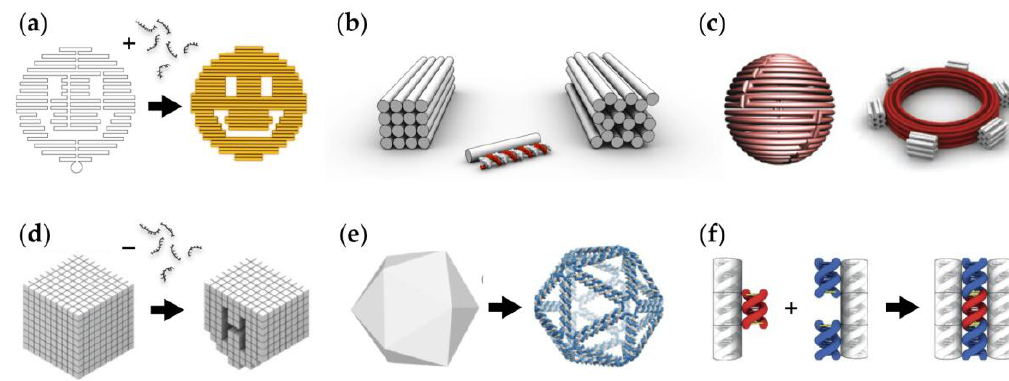
Figure 2. ( a ) A DNA origami technique. A long scaffold strand is folded into a desired shape with the help of short staple strands [14]; ( b ) Multilayer DNA origami in square and honeycomb lattice [15,16]; ( c ) DNA origami with curvatures and bends [17,18]; ( d ) Scaffold-free fabrication of DNA nanoshapes. Numerous target shapes can be fabricated by selecting subsets of strands from the cubic-like ‘molecular canvas’ [19]; ( e ) A fully automated top-down design method to create meshed DNA origami structures [21]; ( f ) DNA origami structures can be glued together by taking advantage of the blunt-end stacking and the shape-complementarity of the origami units [22]. ( a ) is reproduced with permission from [14]. Copyright Nature Publishing Group, 2006. ( b ) is reproduced with permission from [16]. Copyright Nature Publishing Group, 2011. A sphere in ( c ) is reproduced with permission from [17]. Copyright The American Association for the Advancement of Science, 2011. A gear-like object in ( c ) is reproduced with permission from [18]. Copyright The American Association for the Advancement of Science, 2009. ( d ) is reproduced with permission from [19]. Copyright The American Association for the Advancement of Science, 2012. ( e ) is reproduced with permission from [21].